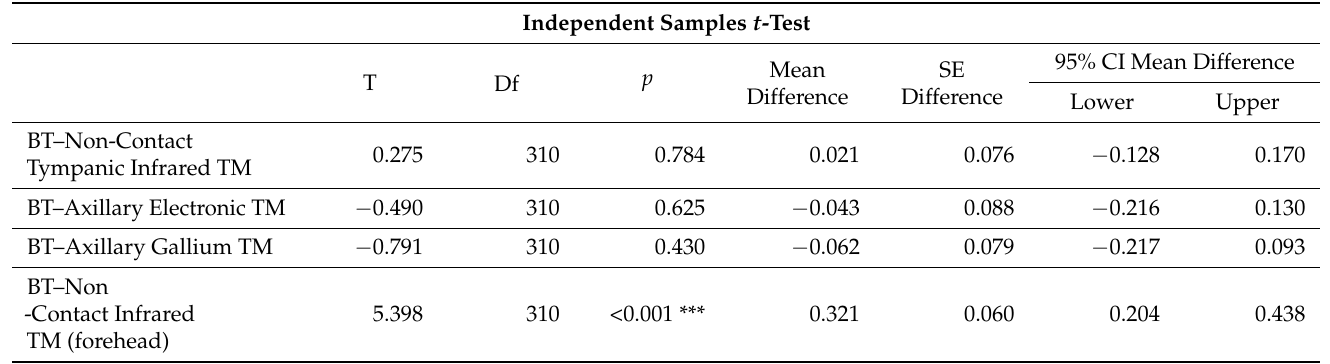
Table 5. Independent samples t -test: gender and body temperature.